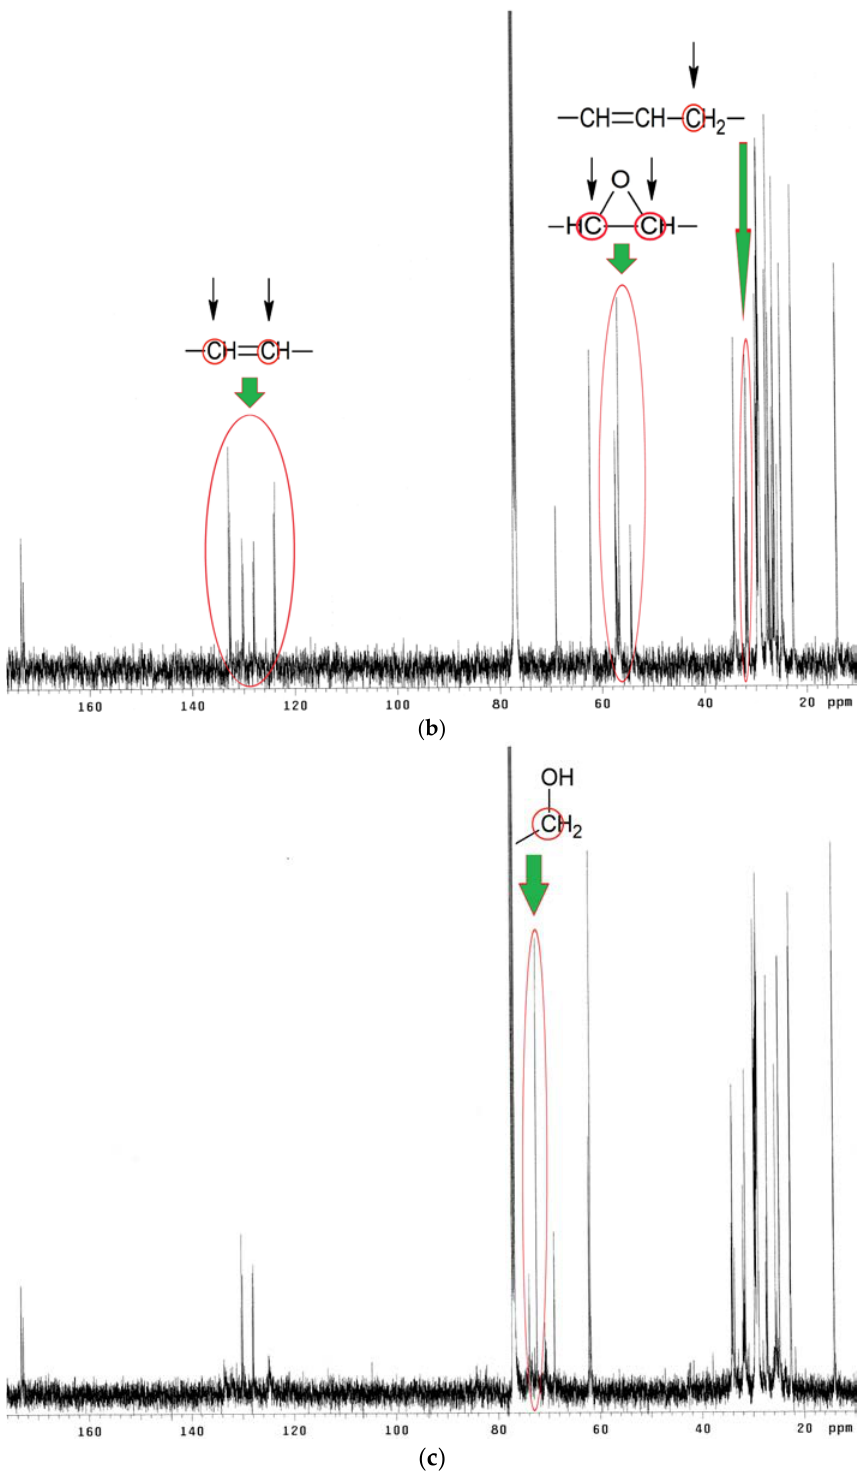
Figure 6. 13 C NMR spectra of ( a ) EPO, ( b ) EPEO, and ( c ) EPB.